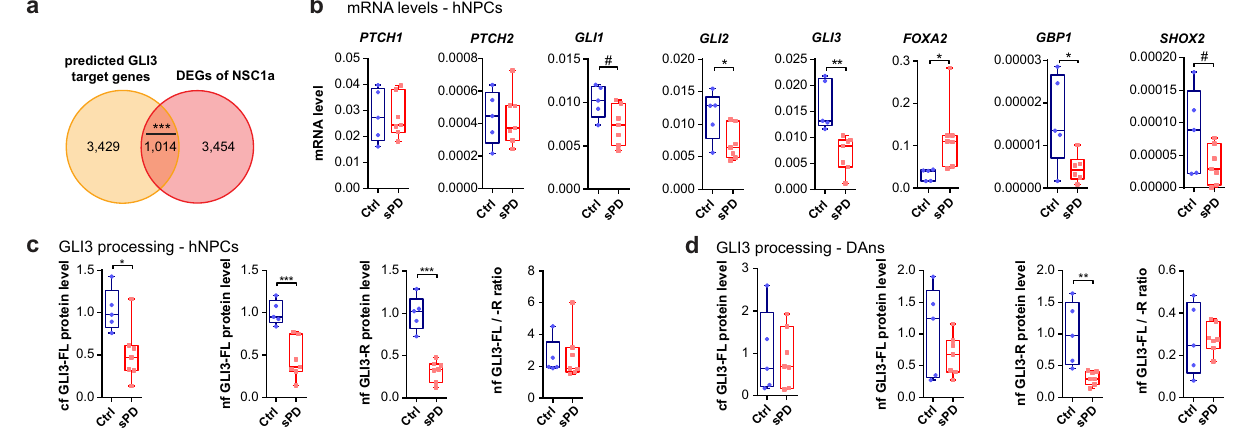
Fig. 6 | Primary cilia dysfunction in sPD. a Overlap of genome wide predicted GLI3targetgenes usingthe MatInspector (Genomatix) withallDEGs fromNSC1a. b Normalized gene expression levels of the SHH receptors PTCH1 , PTCH2 , the SHH transcription factors GLI1 , GLI2 , GLI3 and other signaling targets FOXA2, GBP1, SHOX2 analyzed on mRNA level by RT-qPCR in hNPCs. c Quanti fi cation of full length GLI3 (GLI3-FL) and GLI3 transcriptional repressor (GLI3-R) in the cytoplasmic (cf) or nuclear (nf) fraction of protein extracts from hNPCs and ( d )DAnsanalyzedbyWesternblot.CfandnfGLI3levelswerenormalizedtolevels ofACTBorH1-0,respectively.Allexperimentswereperformedintriplicates, n =5 Ctrl and 7 sPD clones. Boxplots display the median and range from the 25th to